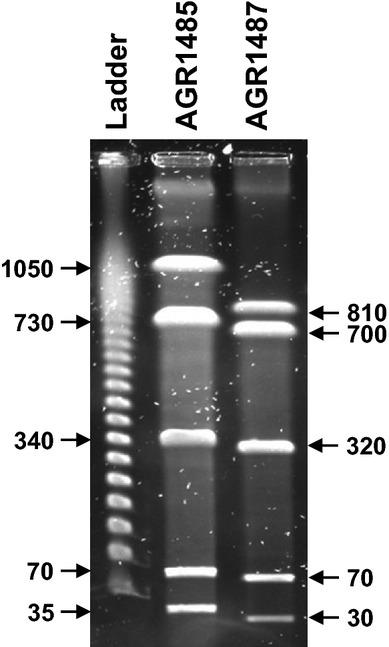
Pulsed-field gel electrophoresis of AGR1485 and AGR1487 genomic DNA digested with restriction enzyme I-CeuI. The marker ladder contained lambda DNA, where the fragments were multimers of 48.5 kb (from gel bottom upwards 48.5, 87, 145.5, 194 kb etc.). The values given are the sizes (kb) of the DNA fragments from the bacterial strains.